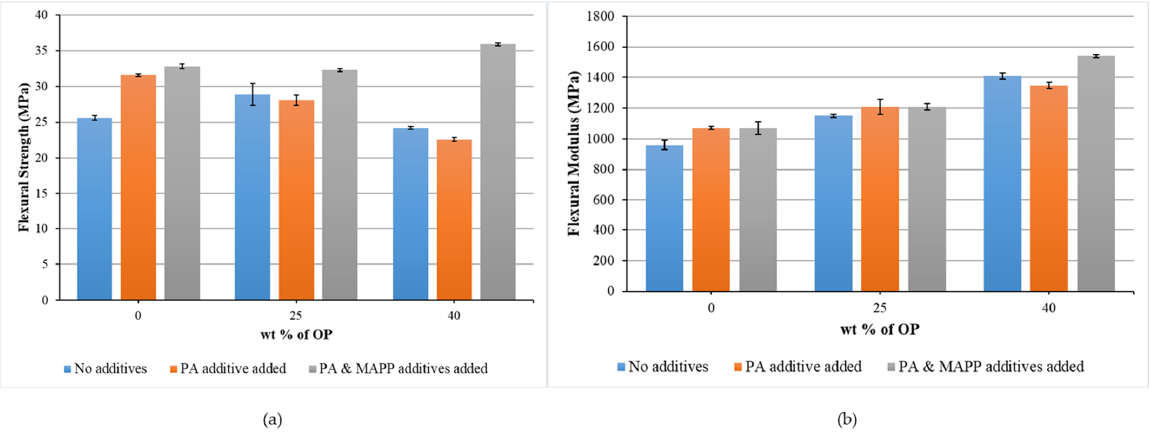
Figure 8. Flexural strength ( a ) and flexural modulus ( b ) of biocomposites as a function of percentage by weight of OP, considering materials without additives, adding PA and adding PA and MAPP,